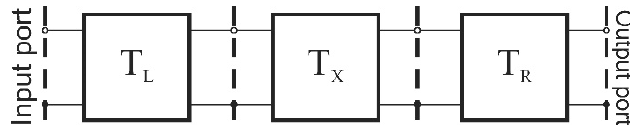
Figure 7. A three-stage cascade network model of the device.